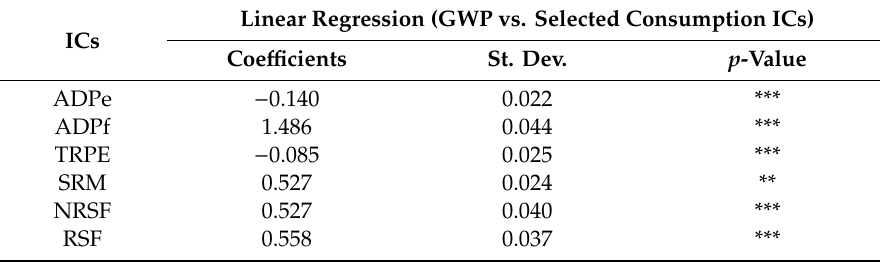
Table 6. Linear regression model summary (after variable